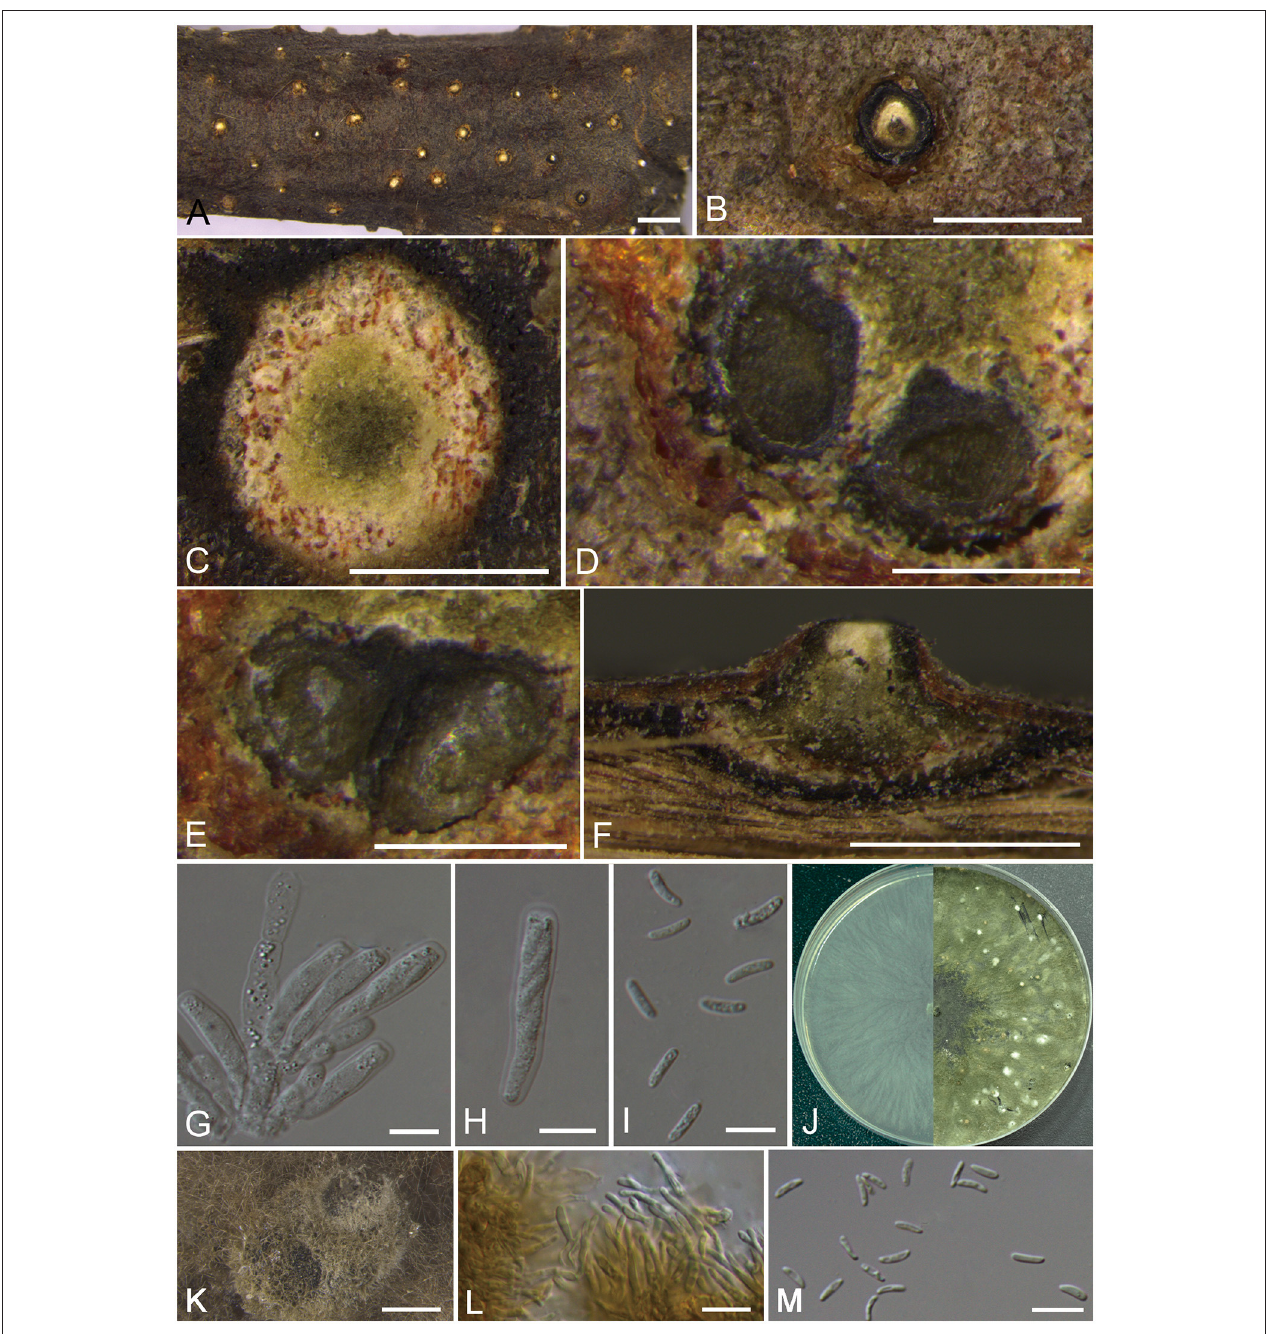
FIGURE 2 | Morphology of Cytospora albodisca (BJFC CF2019908). (A–C) Habit of ascomata on twig. (D,E) Transverse section of ascomata. (F) Longitudinal section through ascomata. (G) Asci and ascospores. (H) Ascus. (I) Ascospores. (J) Colonies on PDA at 3 days (left) and 30 days (right). (K) Conidiomata from culture on PDA. (L) Conidiophores. (M) Conidia. Bars: (A) = 1mm; (B–D), (F) = 250 µ m; (E,K) = 500 µ m; (F,G), (L,M) = 10 µ m.